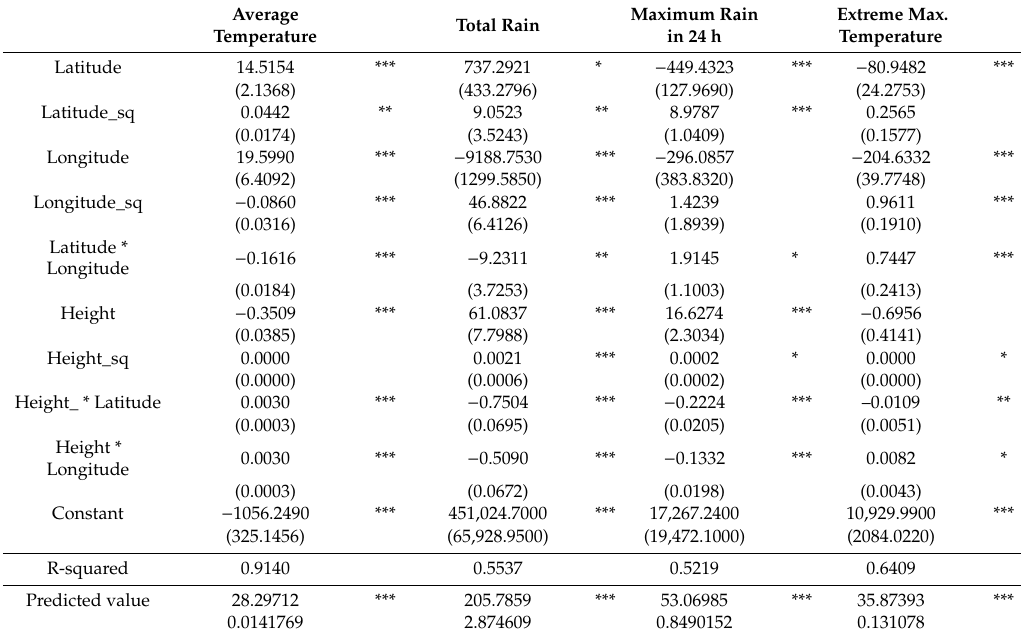
Table A1. Weighted least square regression of climate variables of July 2016 in Nakon Sawan Province. Average Total Temperature